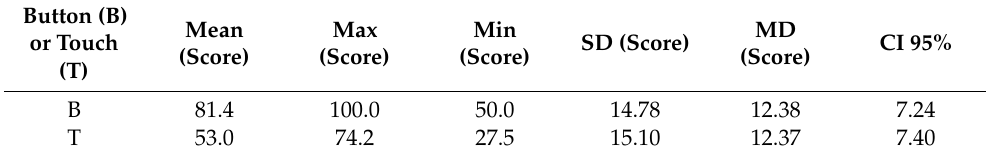
Table 13. SUS scores and statistical results at all driving speeds.